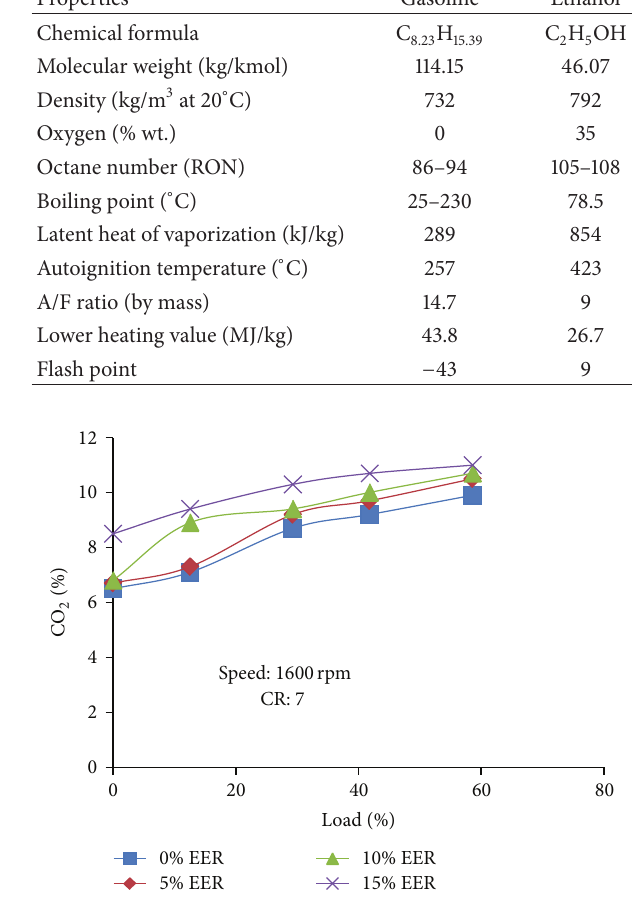
Figure 2: Effect of load on CO 2